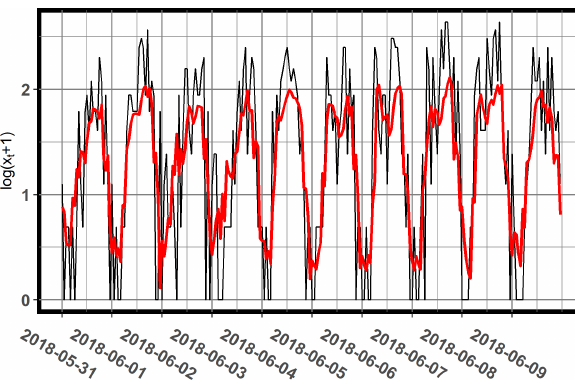
Figure 7: Empirical values and ARMAX(2.2) model fitted values